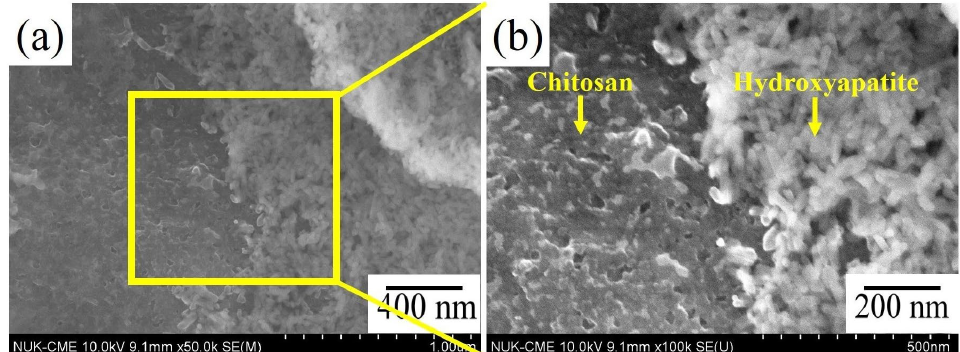
Figure 2. FE-SEM images of a HA/CS composite coating on Ti–25Nb–8Sn alloy prepared under the hydrothermal temperature of 200 °C after scratching with a diamond blade. ( a ) Low magnification image; ( b ) high magnification image.